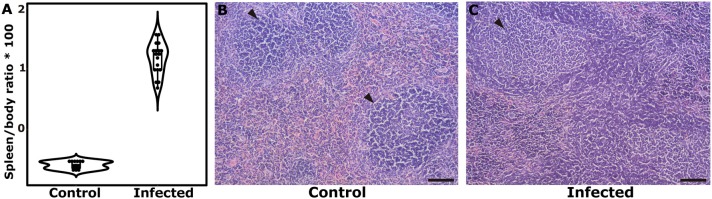
Corroboration of the establishment of splenic disease after 7 weeks of S. mansoni infection. (A) Dot and box plots showing the differences in the median Spleen/body ratio and the interquartile range. (B) Histological aspect in the spleen of a control individual, showing the normal organization of the white and red pulps, with primary follicle predominance (arrow). (C) Histological aspect in the spleen of an infected mouse, showing large lymphatic follicles with prominent germinal centers. Reference bar represents 100 μm.